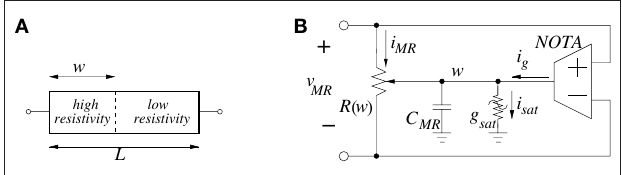
Figure 6 | (A) Memristor “moving wall” model. (B) Simple macro-model circuit for electrical simulations.